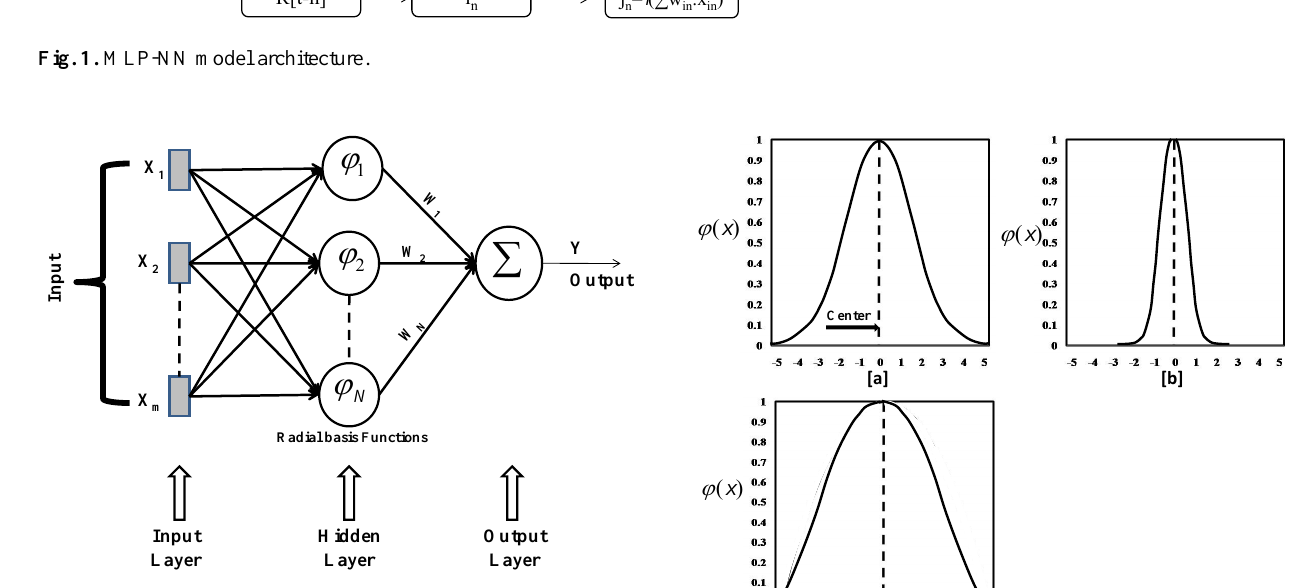
Figure 2: Architecture of Radial basis function neural network Fig. 2. Architecture of radial basis function neural network.